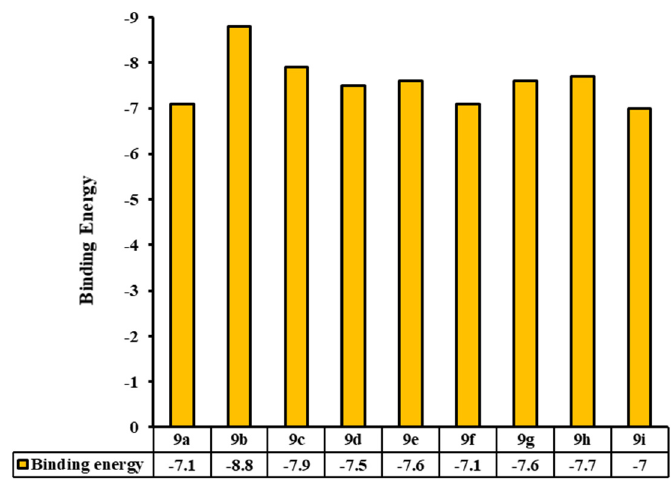
Figure 5. Docking energy values of the synthesized compounds 9(a–i) .